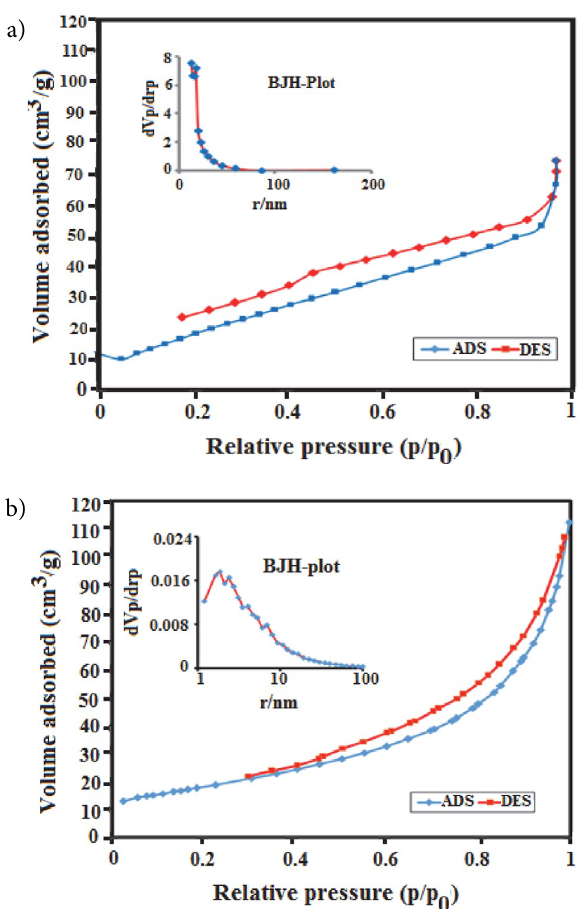
Figure 8. N 2 adsorption-desorption isotherms and pore-size distri- bution curves (the insets) of (a) rGO and (b) the Ag/CuFe 2 O 4 /rGO nanocomposite